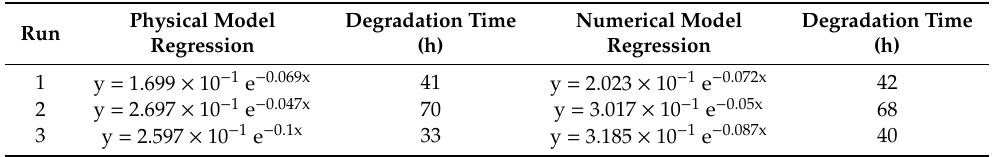
Table 7. Lens degradation results between the physical model and numerical model simulations. Units have been converted from seconds to